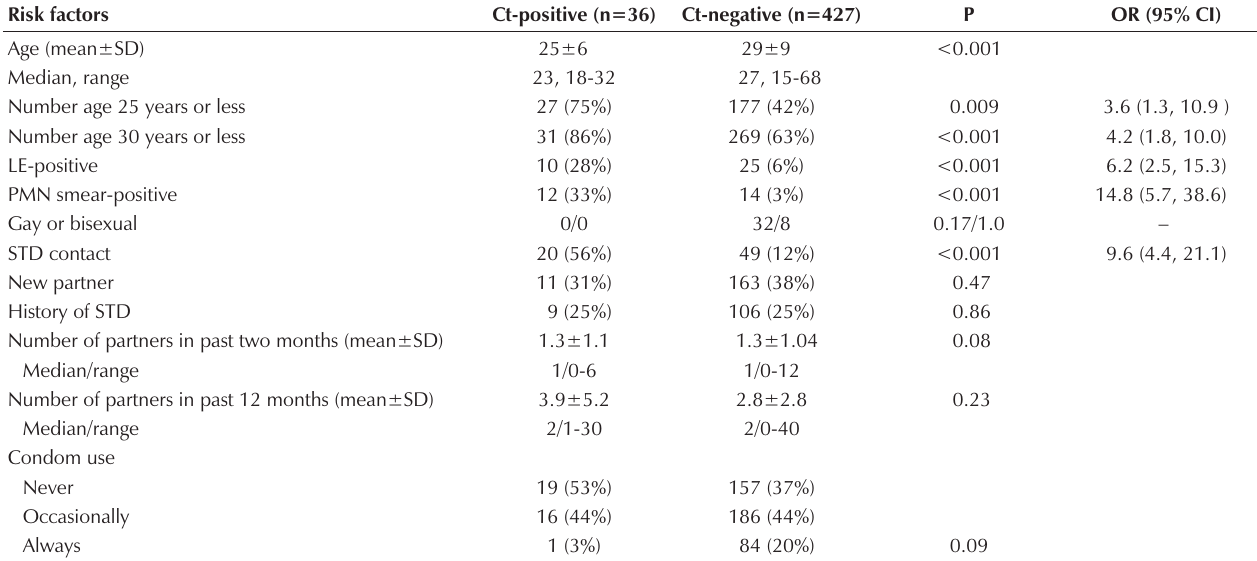
Risk factors for asymptomatic chlamydial infection in men attending a sexually transmitted disease (STD) clinic (n=463, prevalence of infection = 7.8%)